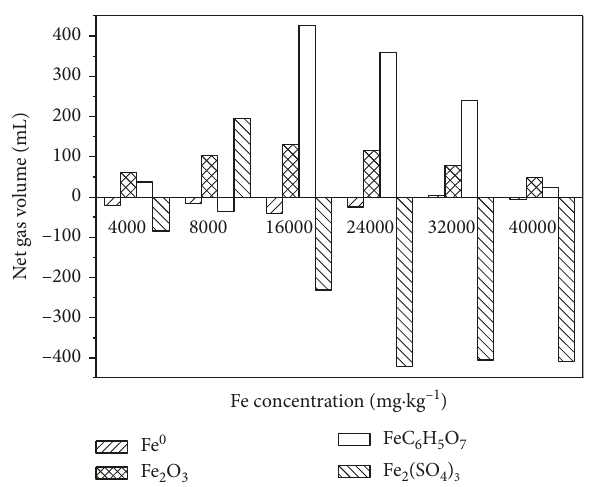
Figure 2: Effect of different iron sources on net gas